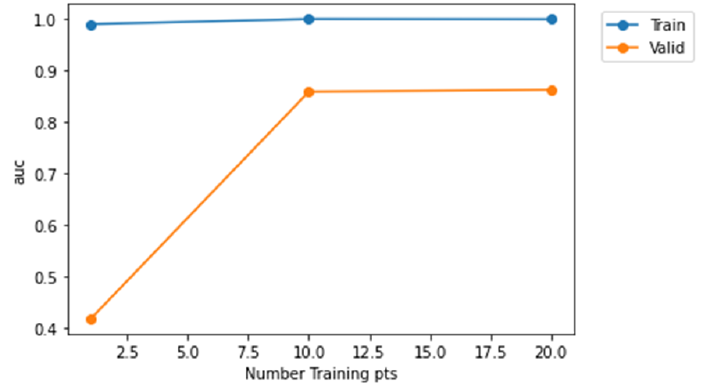
Figure 12. Receiver operating characteristic curve (ROC).